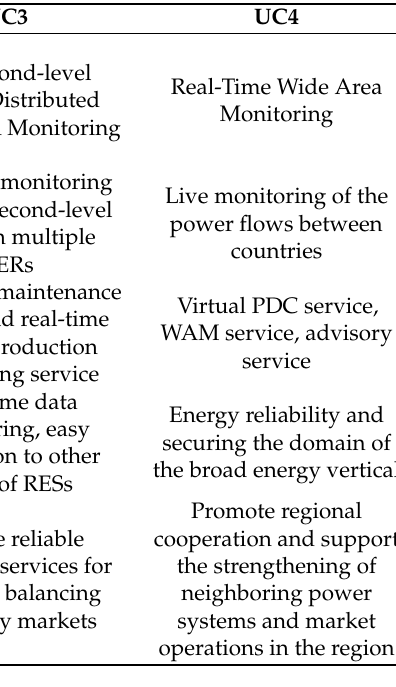
Table 1. Summary of the UCs .